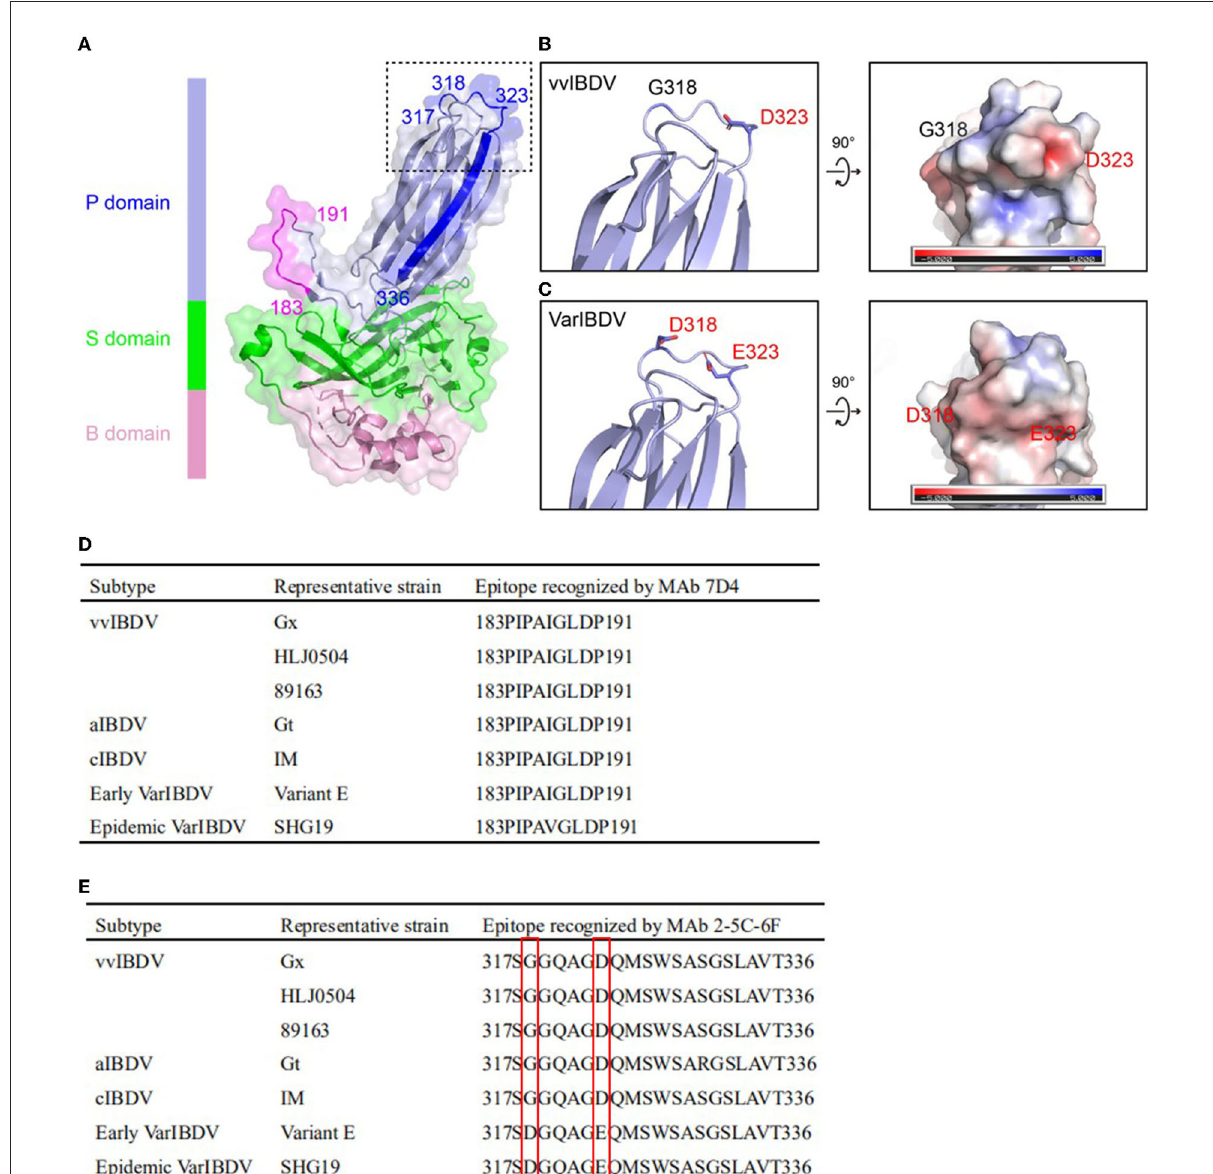
FIGURE3 Location and sequence alignment of MAb antigenic epitopes. (A) Structure of IBDV VP2. P, S, and B domains were marked with different colors. The antigen epitopes of MAbs 7D4 (blue or magenta) and 2-5C-6F (blue or magenta) and the key residues are highlighted, respectively. The antigen epitopes of MAbs 7D4 and 2-5C-6F and key amino acid residues are highlighted. (B) Left: Zoom-in view of dashed box in (A) showing the key residues 318 and 323 of vvIBDV VP2. Right: 90 ◦ rotated view of the left panel showing the electrostatic surface representation of the vvIBDV. The side chains of residues 318 and 323 are displayed as a stick. (C) Left: Zoom-in view of dashed box in (A) showing the key residues 318 and 323 of varIBDV VP2 predicted by using the I-TASSER algorithm. Right: 90 ◦ rotated view of the left panel showing the electrostatic surface representation of varIBDV. The side chains of residues 318 and 323 are displayed as stick. (D) Amino acid sequence of the antigen epitope recognized by MAb 7D4 among different subtype strains of IBDV. (E) Amino acid sequence of the antigen epitope recognized by the MAb 2-5C-6F among different subtype strains of IBDV. The amino acid residues 318 and 323 of the antigen epitope recognized by the MAb 2-5C-6F are highlighted.